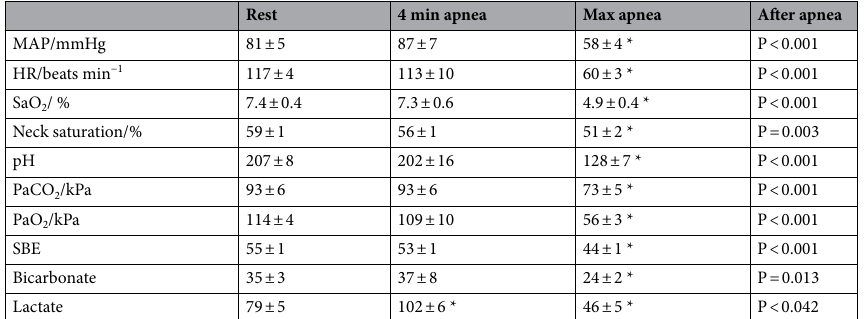
Table 2. Hemodynamic parameters and blood gas results at rest, after 4 min apnea and at end of apnea (326 ± 19 s). Values are means ± Standard Error of Means. *P < 0.05 vs. rest and ***P < 0.001. MAP mean arterial pressure, HR heart rate, SBE standard base excess, SaO 2 arterial oxygen saturation. PaCO 2 partial pressure of carbondioxide, PaO 2 Partial pressure of oxygen.